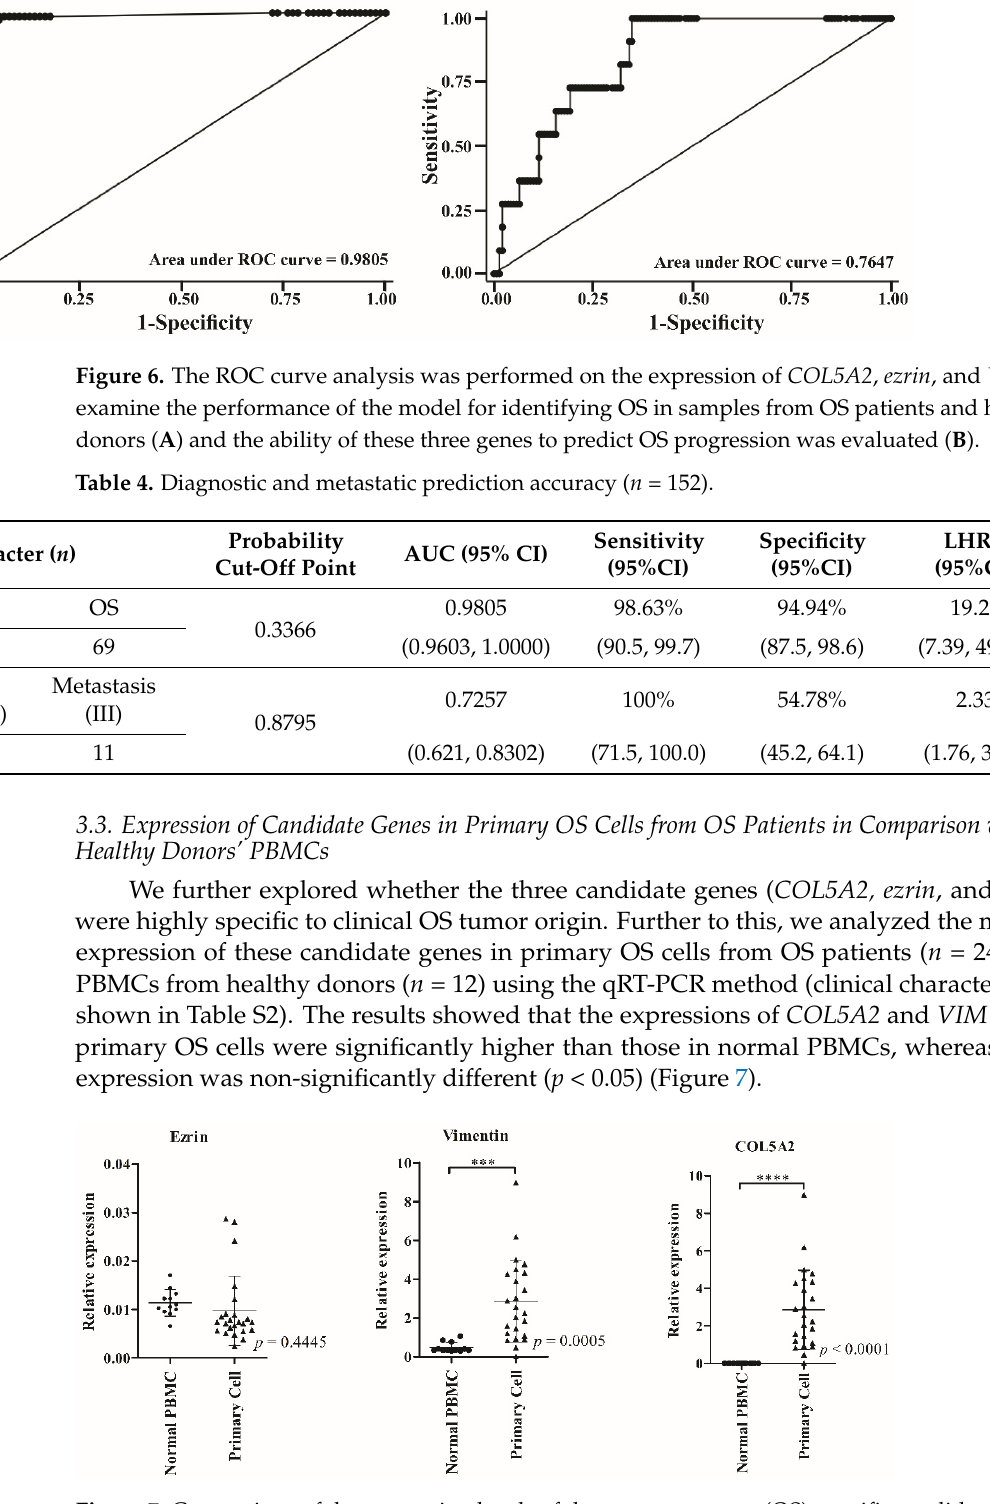
between primary OS cells ( n = 24) and normal PBMCs ( n = 12) using the qRT-PCR technique. The